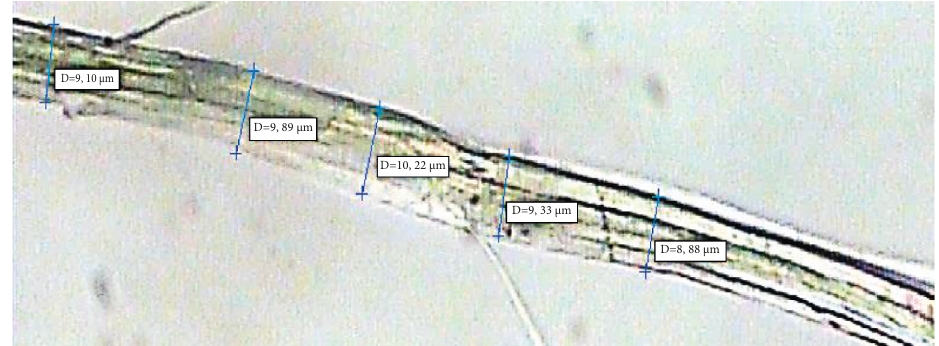
Figure 3: Fiber diameter under optical microscope (40x). Table 2: Comparison table of physical and tensile properties of CDAF with other natural fibers [45, 46, 60, 63].